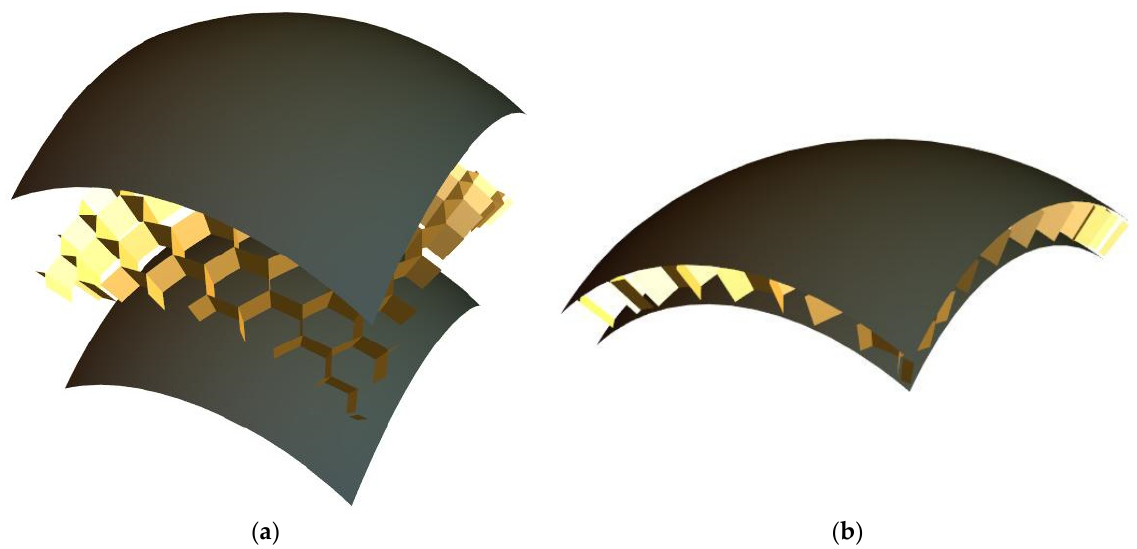
Figure 3. A fragment of a spherical sandwich shell ( a ) before and ( b ) after assembly (not to scale).